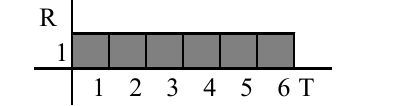
Fig. 1. Activity under category A (